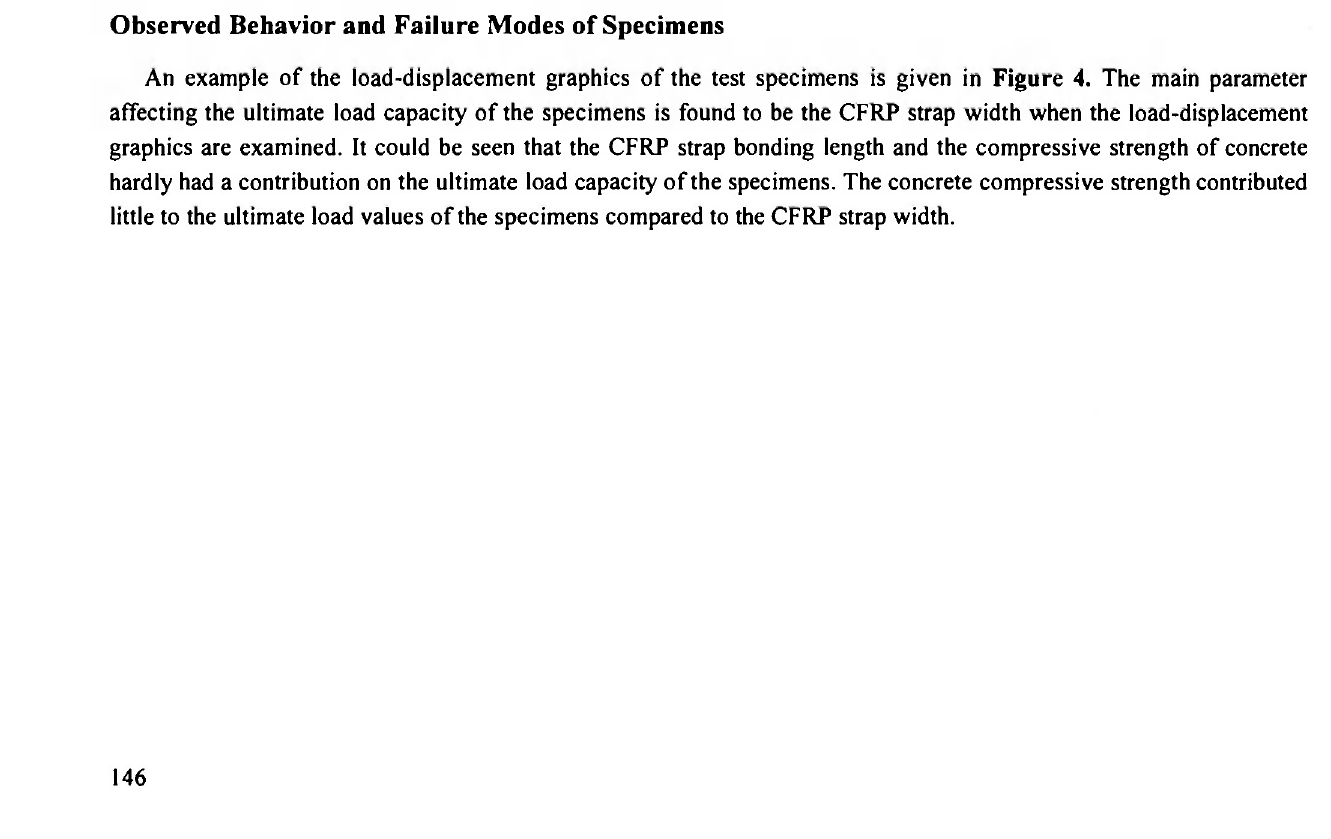
Fig. 3: Test Setup and